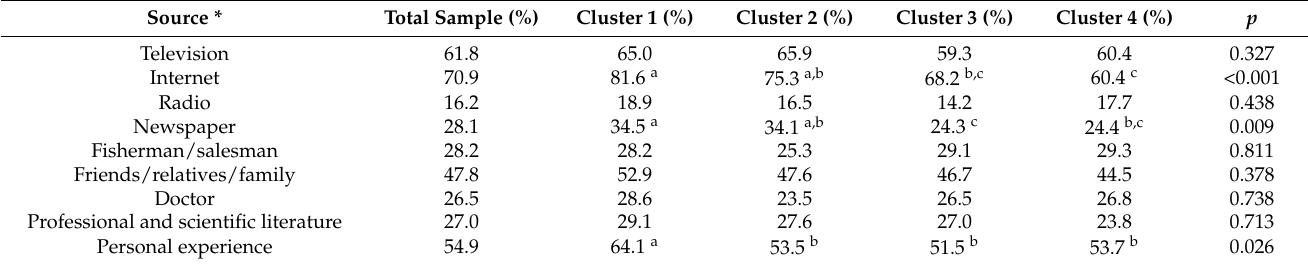
Table 8. Source of information about fishery products for Croatian fishery consumers (n =